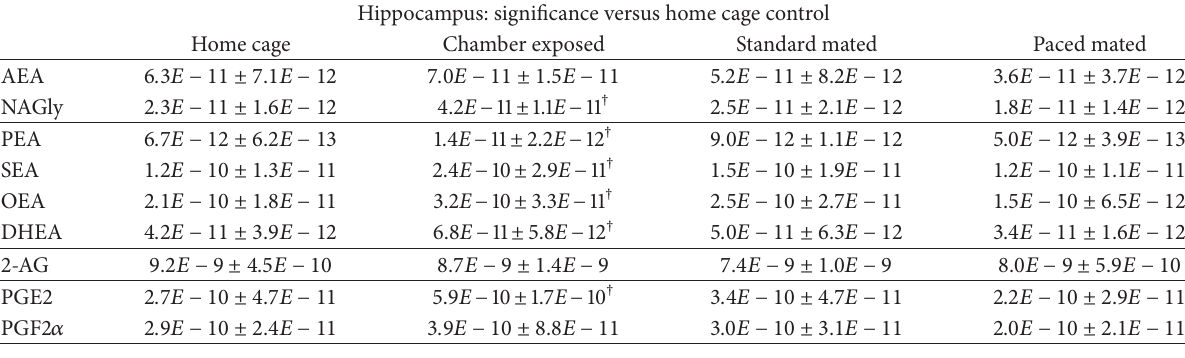
Table 4: Hippocampus